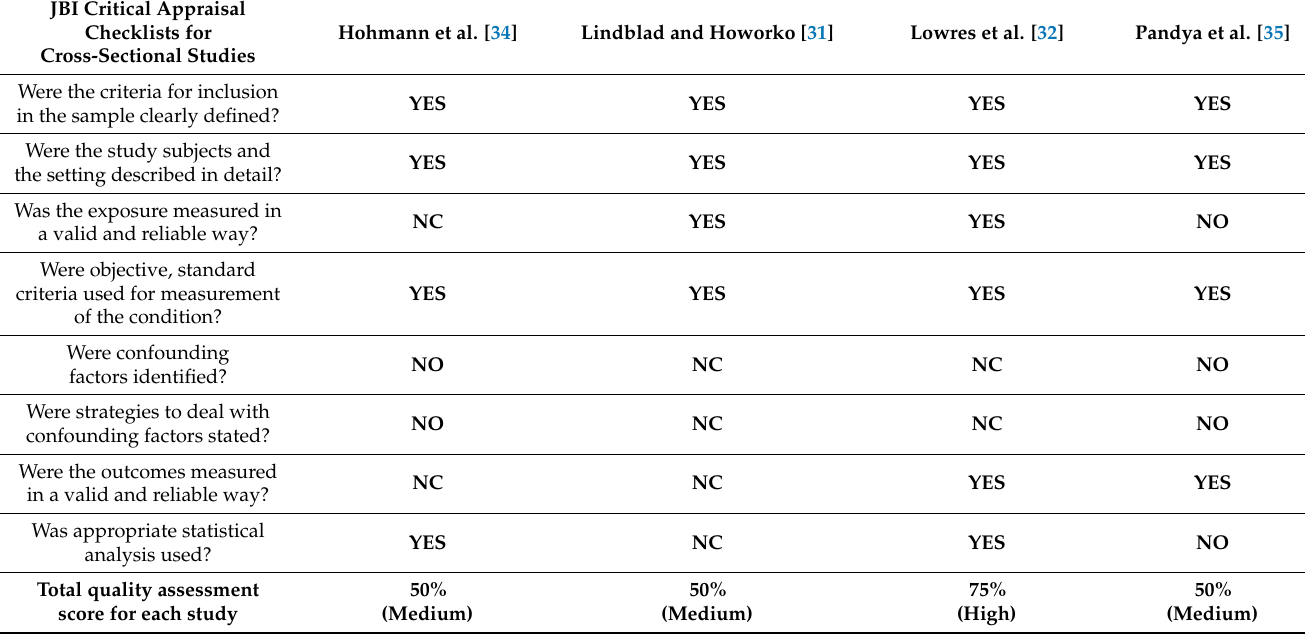
Table 2. Assessment of included cross-sectional studies using Joanna Briggs Institute (JBI) critical appraisal tools (where NC indicates